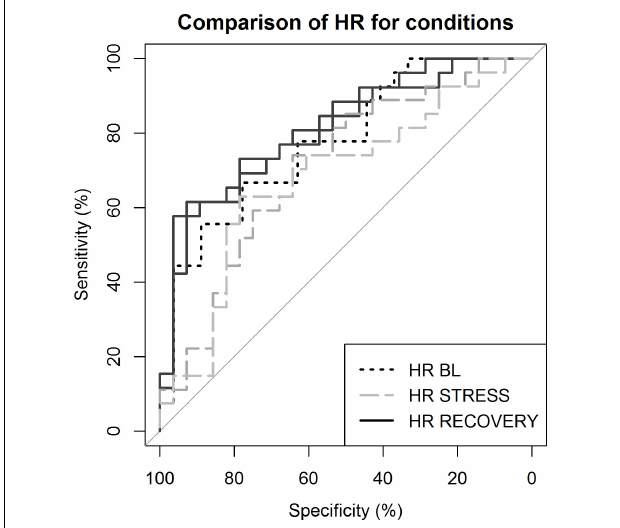
FIGURE 4 | Receiver operating characteristic curves demonstrating sensitivity and specificity of the classification. Classification based on heart rate (HR) during various conditions. BL, baseline; STRESS, stress 1 and 2; and RECOVERY, recovery 1 and